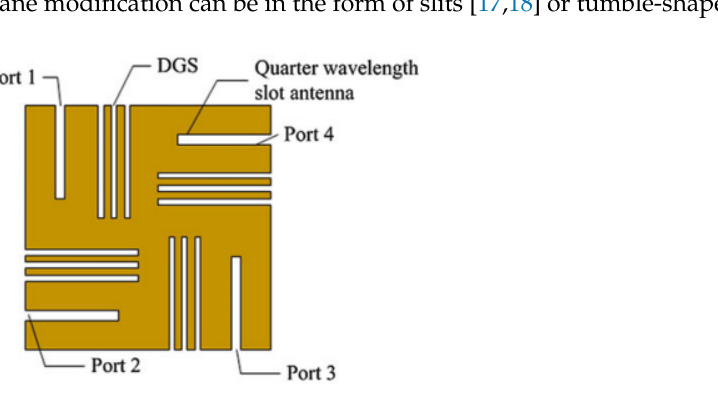
Figure 2. Orthogonally polarized slot antenna DGS [16].